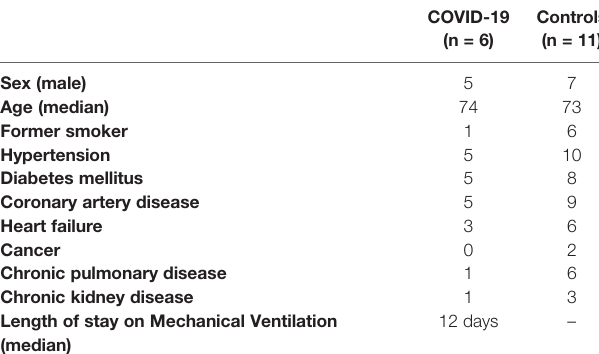
TABLE 1 | Clinical data from the baseline of COVID-19 and control